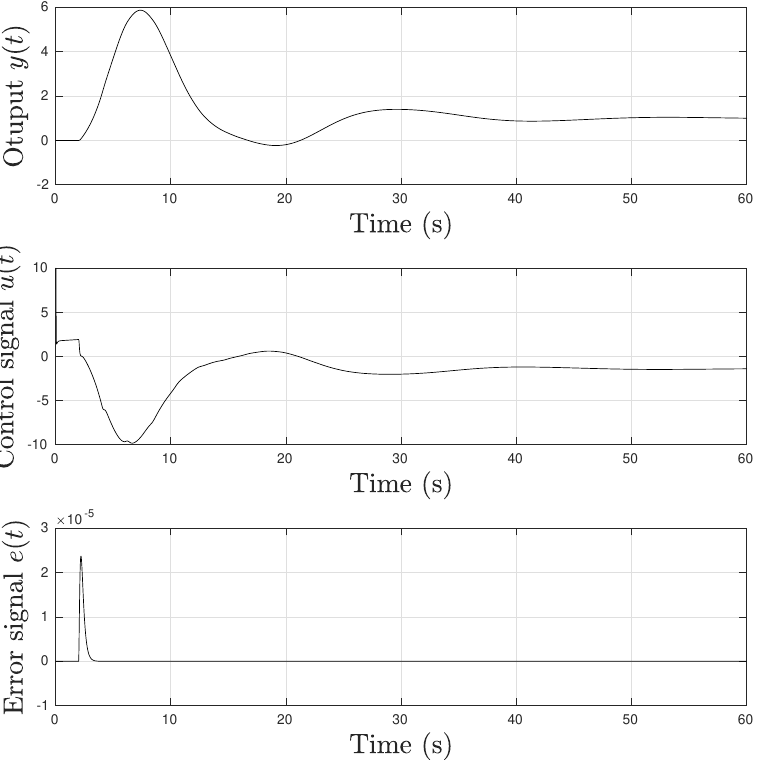
Figure 5. Response for one unstable pole with parameters variations for τ = 0.25.